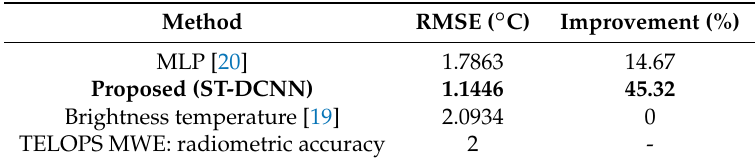
Table 4. Comparison of the temperature estimation in terms of the